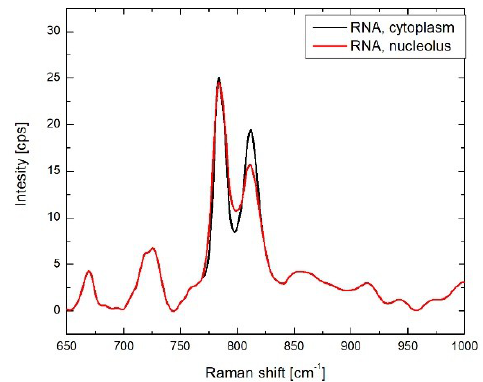
Figure 3. Raman spectra of cytoplasm (black) and nucleolar (red) RNA in the 650–1000 cm −1 wavenumber range used in BCAbox .